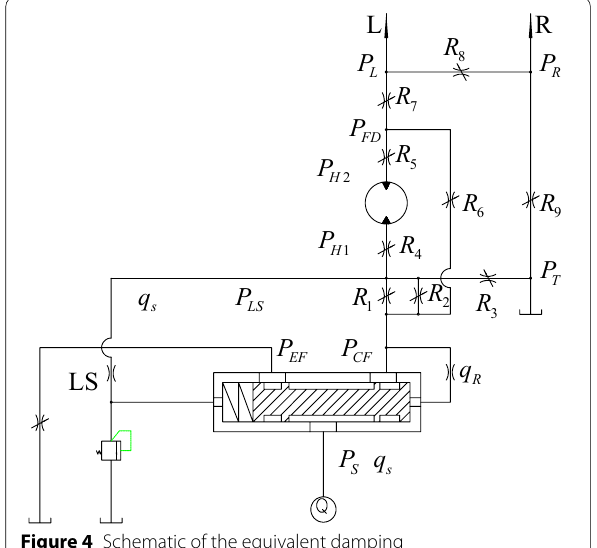
Figure 4 Schematic of the equivalent